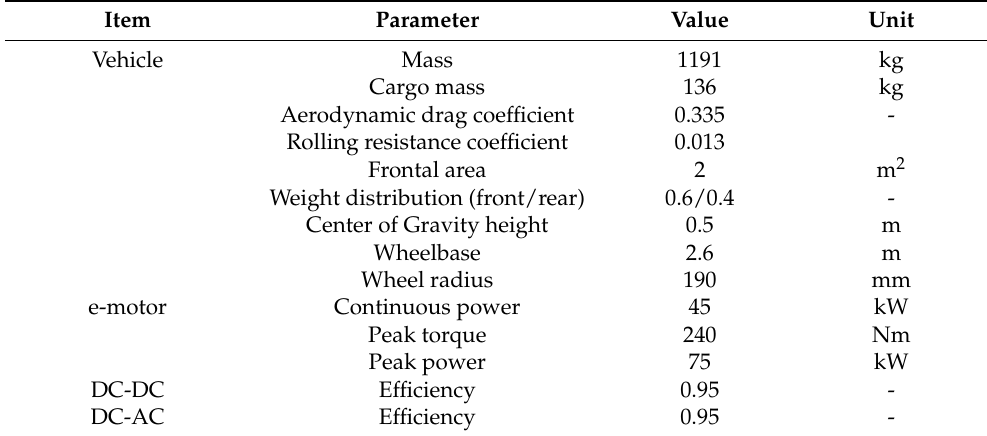
Table 1. Main FCHV parameters. Item Parameter Value Unit Vehicle